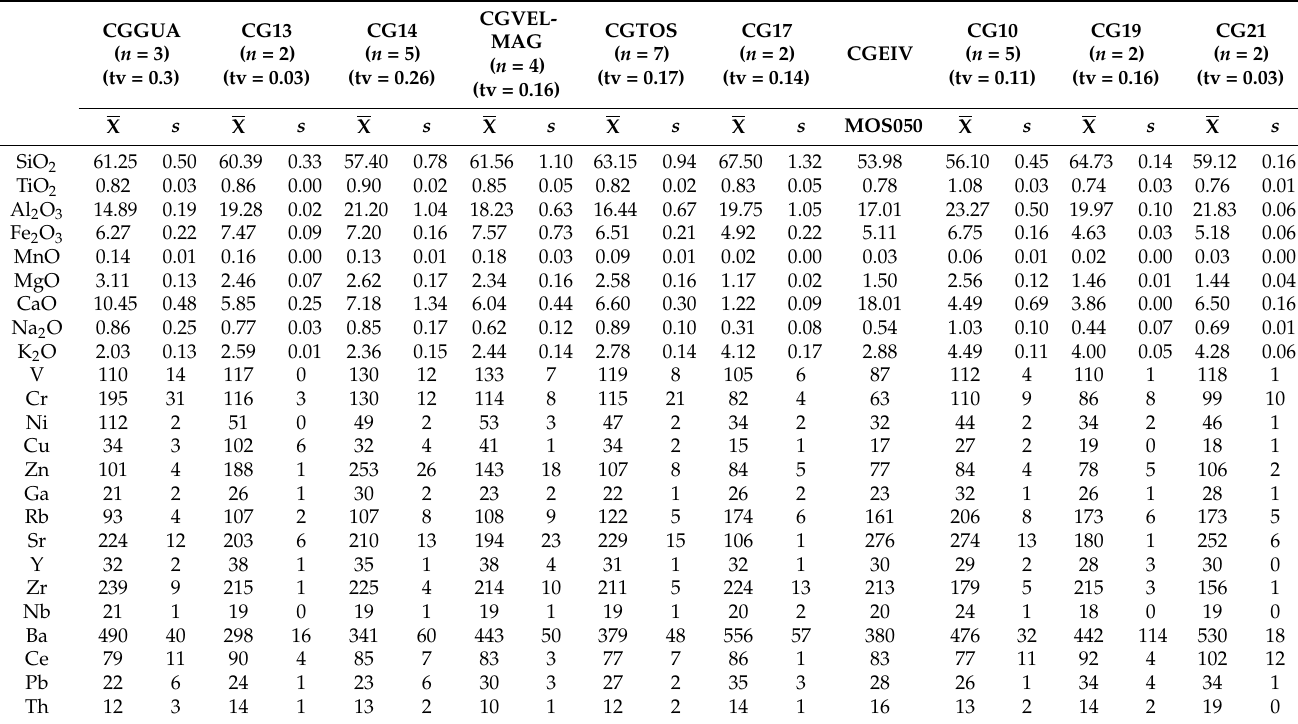
Table 3. Mean (X), standard deviation ( s ), and total variation (tv) of the groups of more than two individuals and the values of individual MOS050 in group CGEIV (as normalised values). Major and minor elements (expressed as oxides) in w %. Trace elements in w